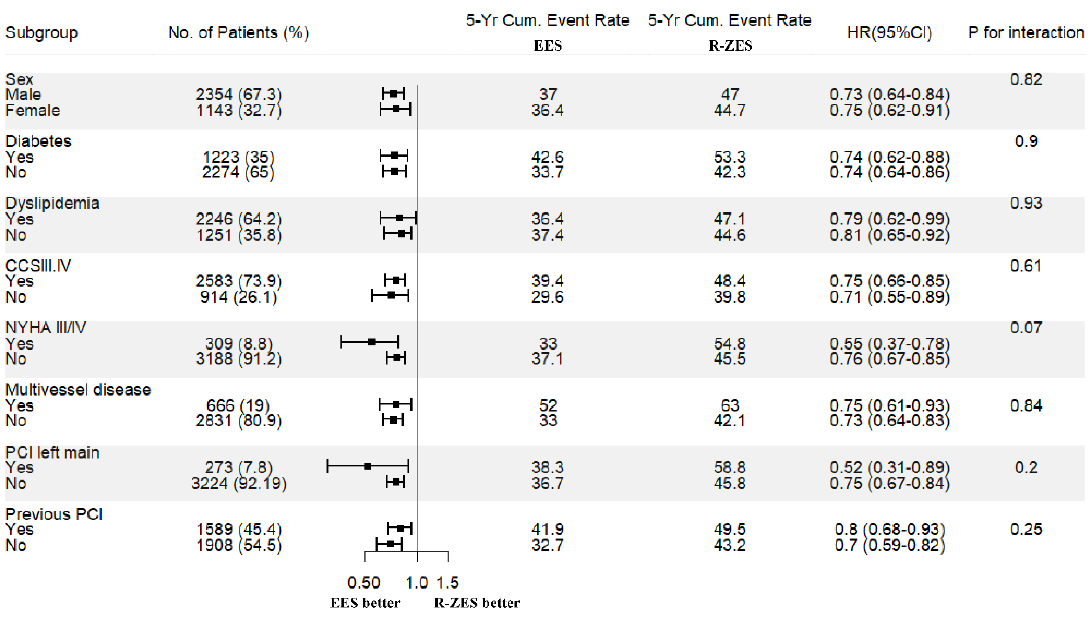
Figure 6. Forest plot analysis of the prespecified subgroups. CCS, Canadian Cardiovascular Society Grading Angina; NYHA, New York Heart Association heart failure classification; PCI, percutaneous coronary intervention.